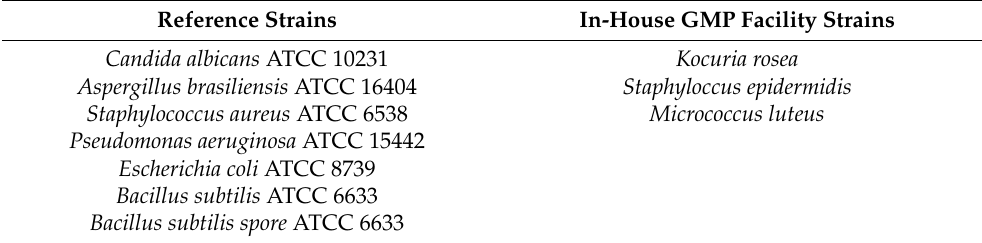
Table 1. Microbial